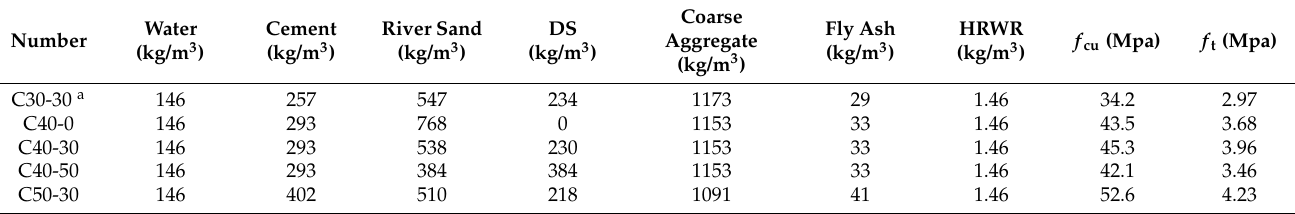
Table 3. Mix proportions of concrete.